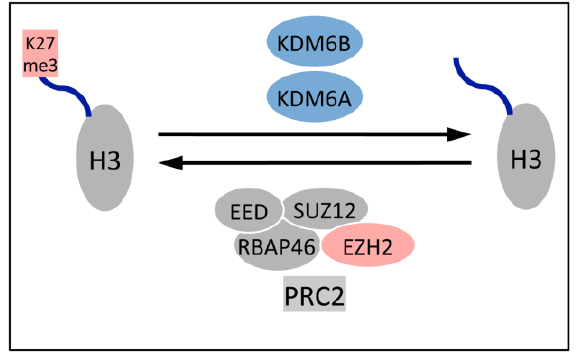
Figure 3. PRC2 mediated gene silencing is reversible. The EZH2 histone methyl transferase in PRC2 silences gene expression by adding the trimethyl mark on lysine residue 27 of histone H3, and this mark can be removed by one of the two H3K27 specific demethylases, KDM6A or KDM6B. See text for